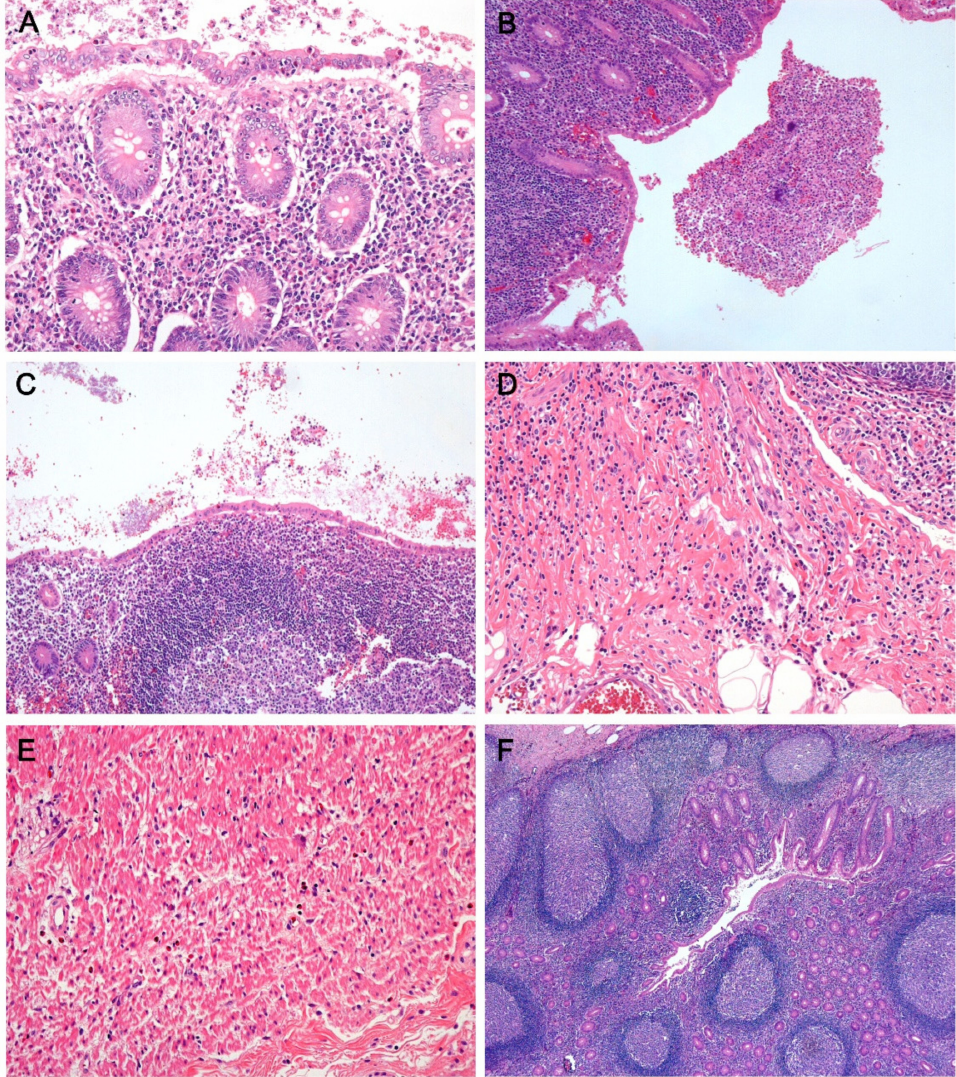
Figure 1. Variable histopathologic findings in negative appendectomy specimens (hematoxylin and eosin. ( A ) Mucosal inflammation. Neutrophilic infiltration is observed within the crypt epithelium and lamina propria. ( B ) Luminal inflammation. Intraluminal neutrophilic aggregates are seen. ( C ) Mucosal flattening. The surface mucosa is lined by cuboidal or flattened epithelial cells with loss of goblet cells. ( D ) Submucosal inflammation. Mixed inflammatory cells, including neutrophils, infiltrate the submucosal layer without involvement of the proper muscle layer. ( E ) Eosinophilic infiltration in the proper muscle layer. ( F ) Lymphoid follicular hyperplasia. ( A , D , E : × 200, B , C : × 100, F : ×